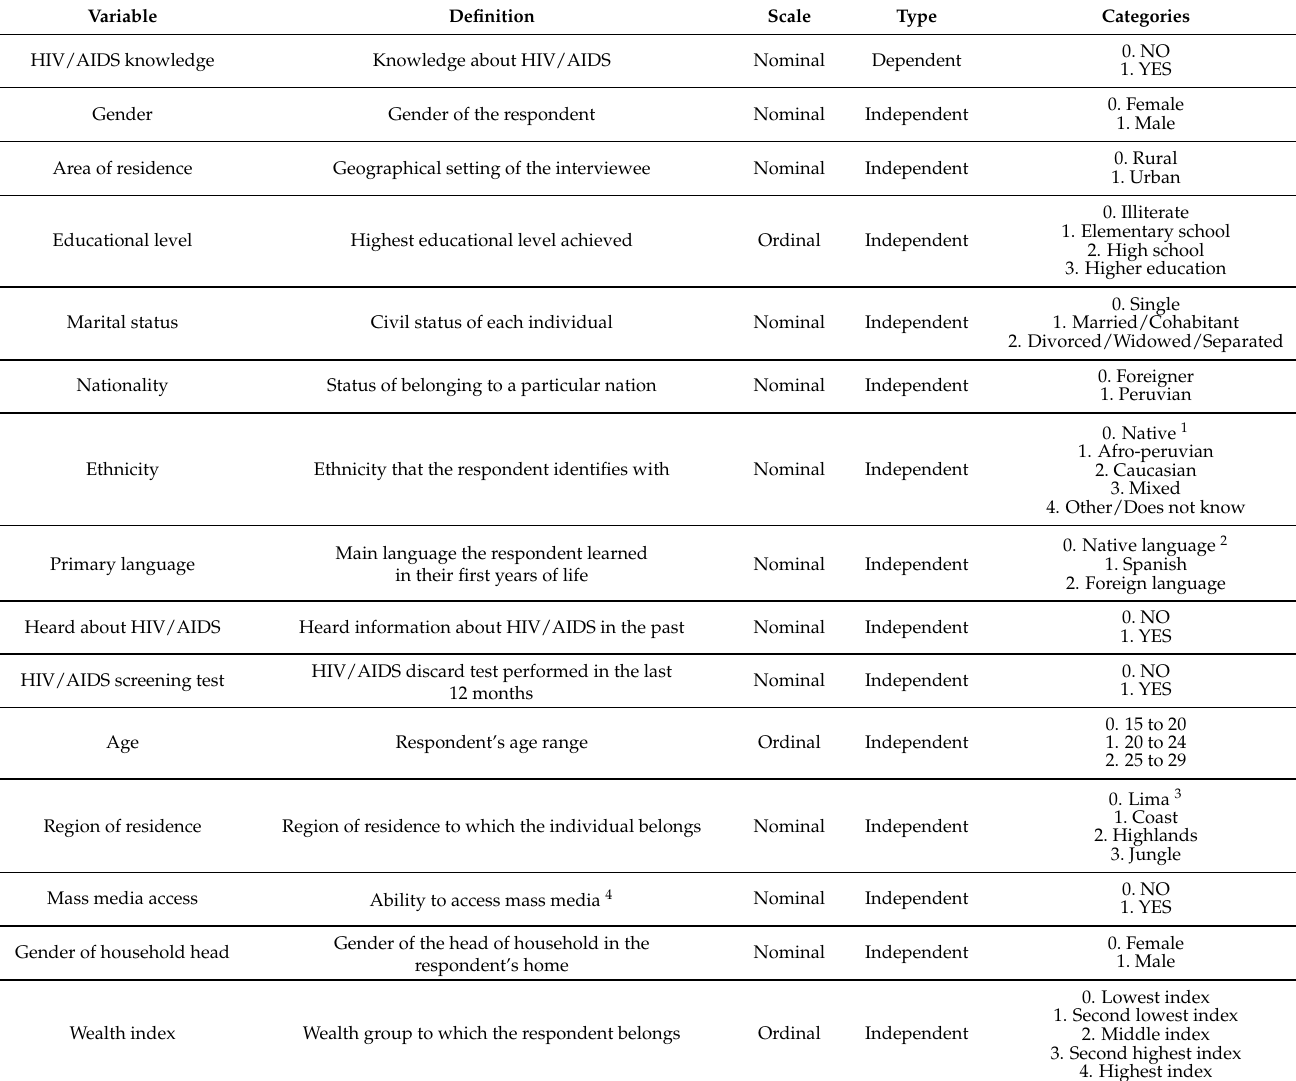
Table 1. Operational definition of the socio-demographic, economic and family factors used in the